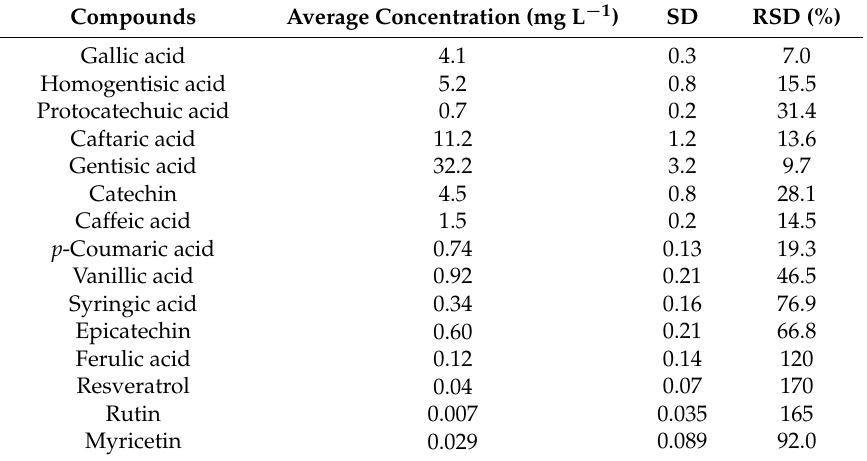
Table 1. Average concentration values of polyphenols in the set of samples under